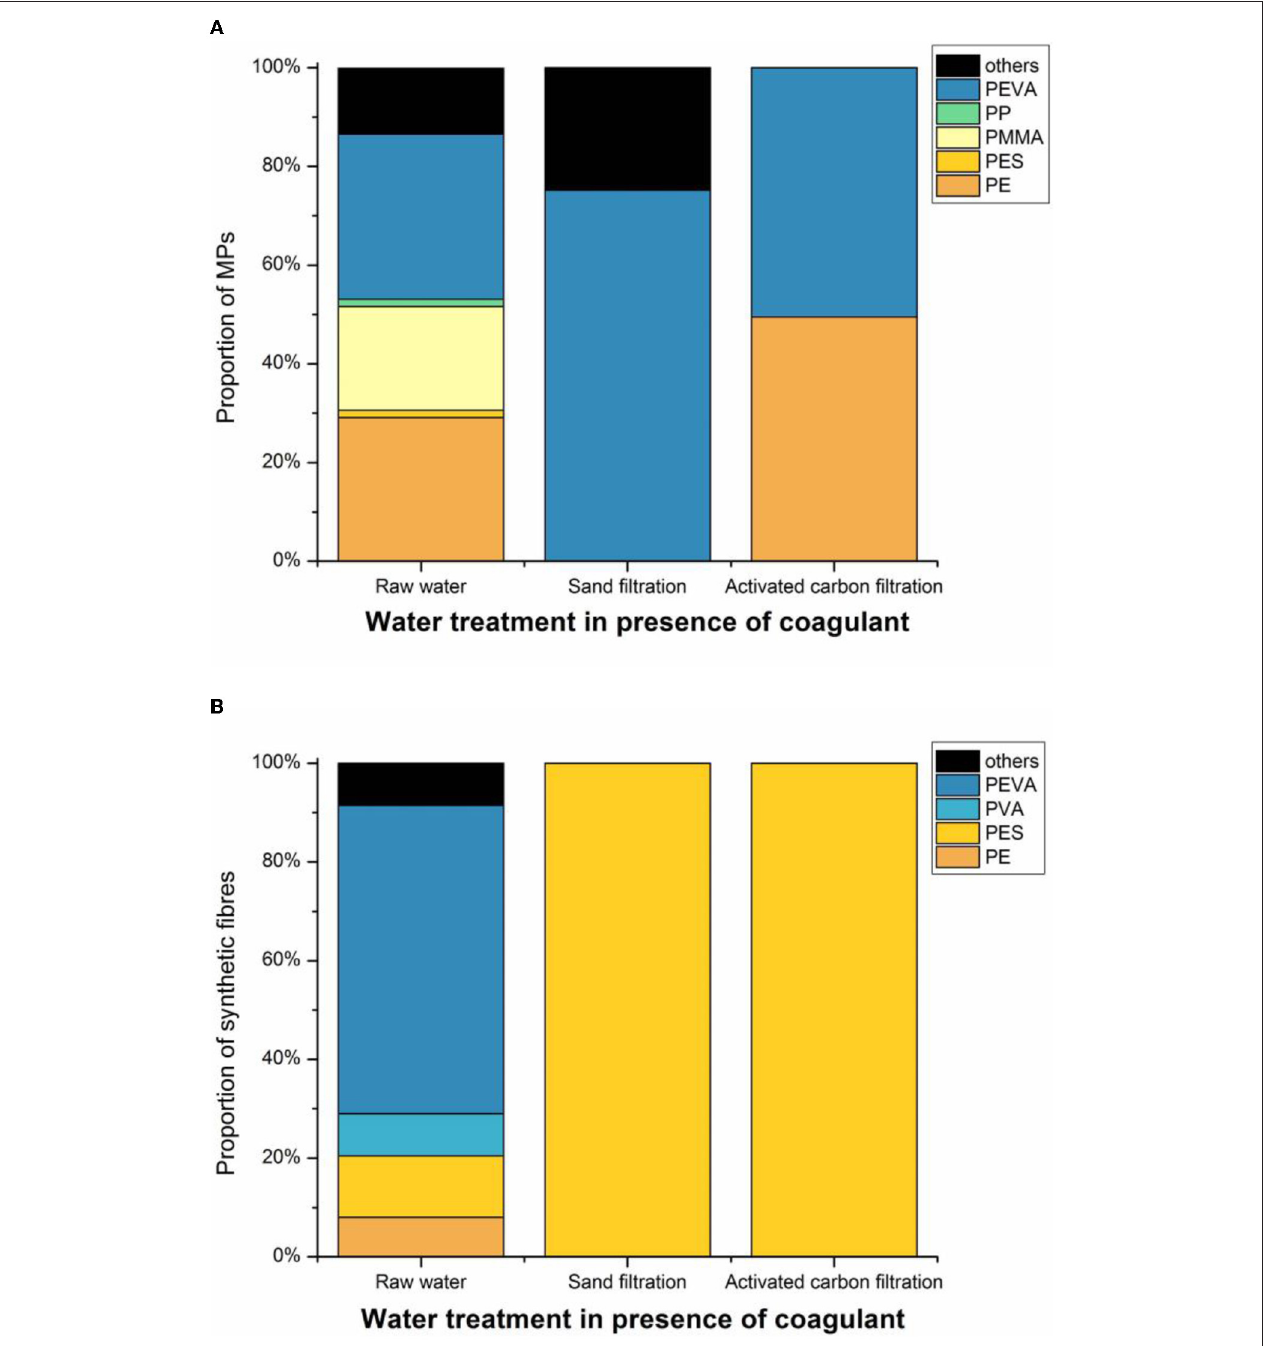
FIGURE 6 | Chemical composition of MPs (A) and synthetic fibres (B) in raw water, after sand filtration and after activated carbon filtration in presence of coagulant.